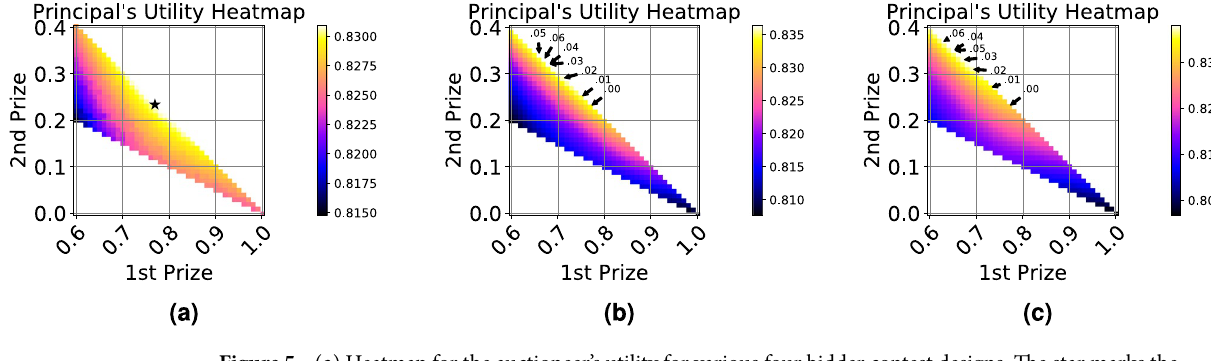
Figure 5. ( a ) Heatmap for the auctioneer’s utility for various four bidder contest designs. The star marks the optimal design. ( b ) Heatmap with realized bids drawn from an interval [bid − d , bid + d ] uniformly. Plotted on top of the heatmap are arrows to the optimal designs for different values of d annotated on the map. ( c ) Heatmap with realized bids drawn from an interval [bid − d , bid + d ] according to Beta( 1 2 , 1 2 ), d = 0.06 .